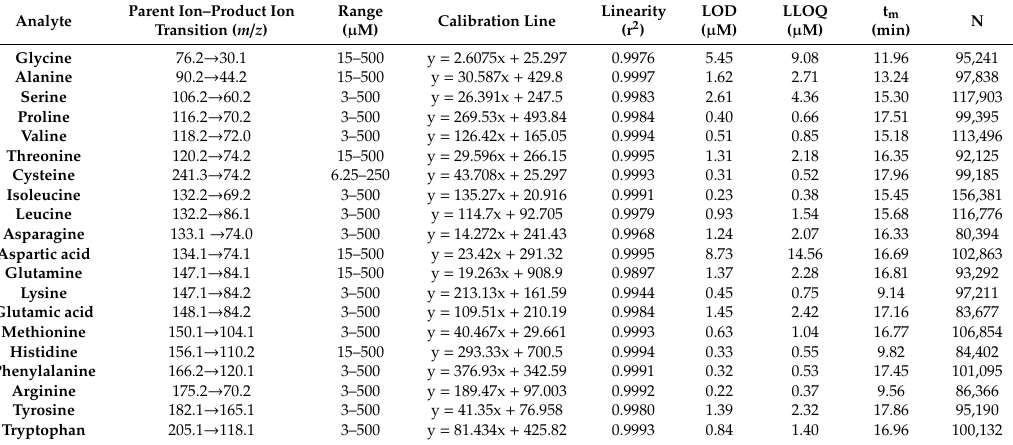
Table 2. Calibration and selected analytical parameters of the CE-MS / MS method for 20 amino acids in human urine